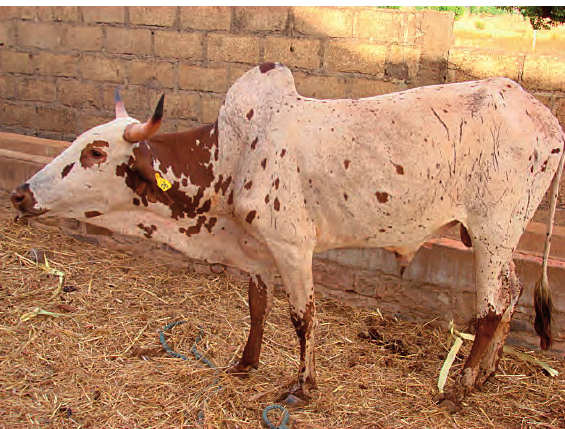
FIG. 2 Acute gross lung lesion of CBPP. Note the pronounced interlobular thickening with marbled appearance Source: M. Niang; FAO Project (2008)-LCV, Bamako-